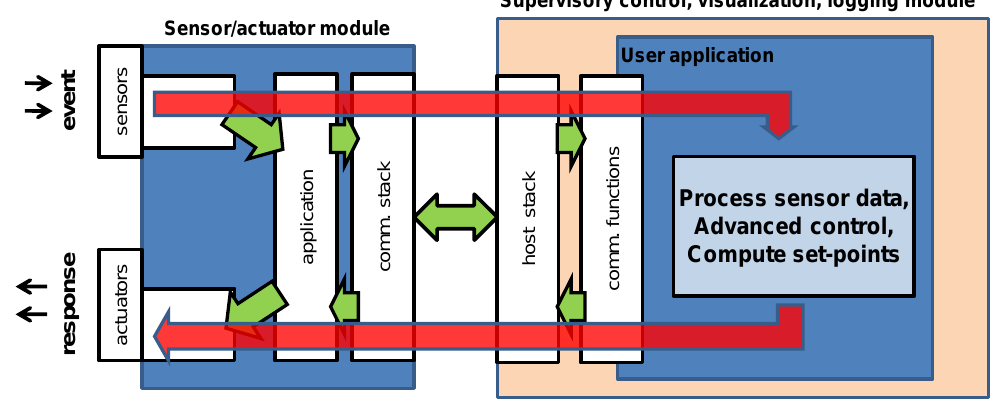
Figure 3. Closed control loop